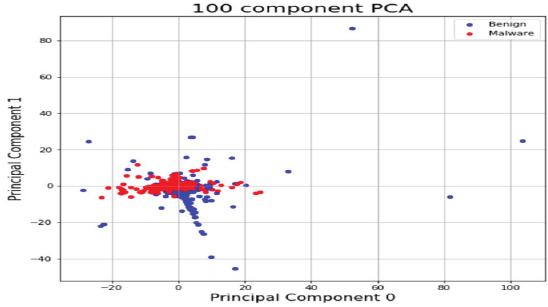
Figure 10. Feature vector distribution of Windows binary.